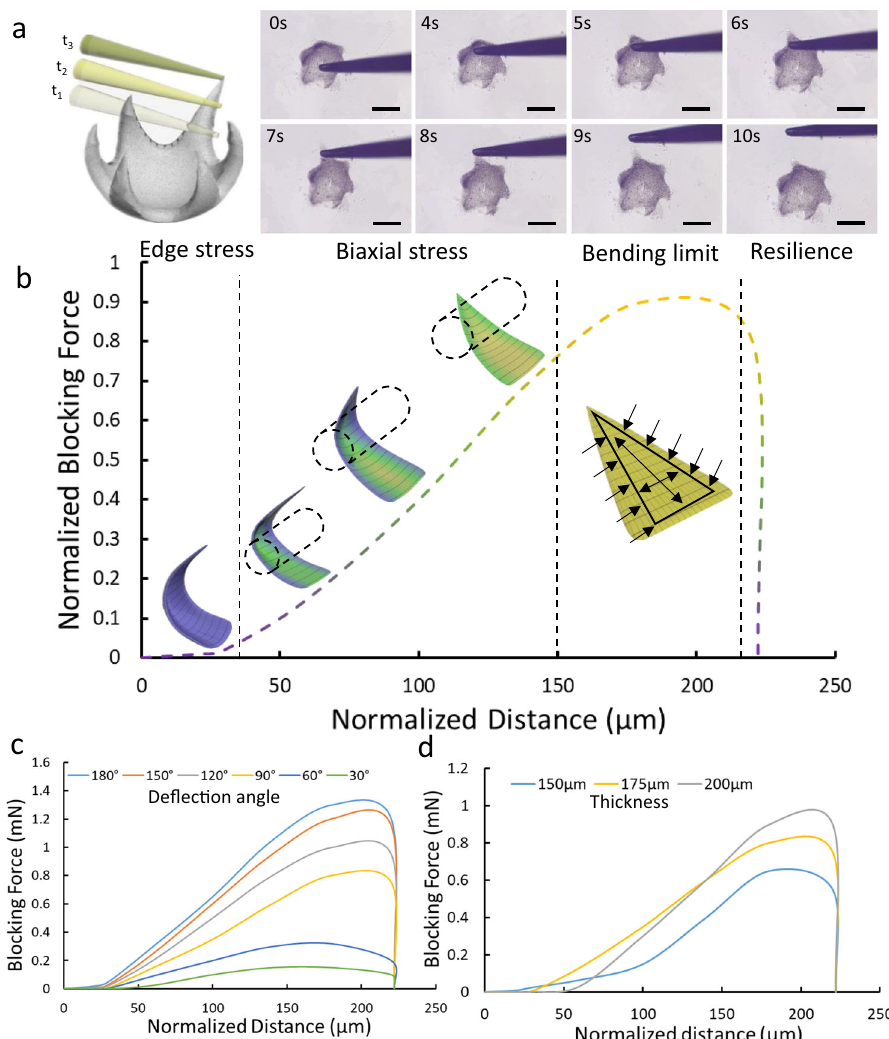
Fig. 4 Mechanical test of an ISME. a Schematic illustration and images of the contact between the force transducer and the fi nger of an ISME at different distances. Scale bar: 250 μ m. b Schematic illustration of ISME deformation and the ISME-generated strain force under elastic deformation. The tip of the force transducer fi rstly contacts with the edge of the ISME fi nger, which generate a small force named edge stress. And then, the tip of the force transducer contact with the long axis of the ISME fi nger. In this process, there are both edge stress and stress of long-axis, which is named biaxial stress. With the force transducer moving forward to the tip of the ISME fi nger, the force transducer give the bending limit and following the resilience of the ISME fi nger. The colouration of each state is arbitrary, which only gives the sequential process. c Blocking forces generated by ISME fi ngers with different de fl ection angles. d Blocking forces generated by ISME fi ngers with different thicknesses. Source data is provided as a Source Data fi